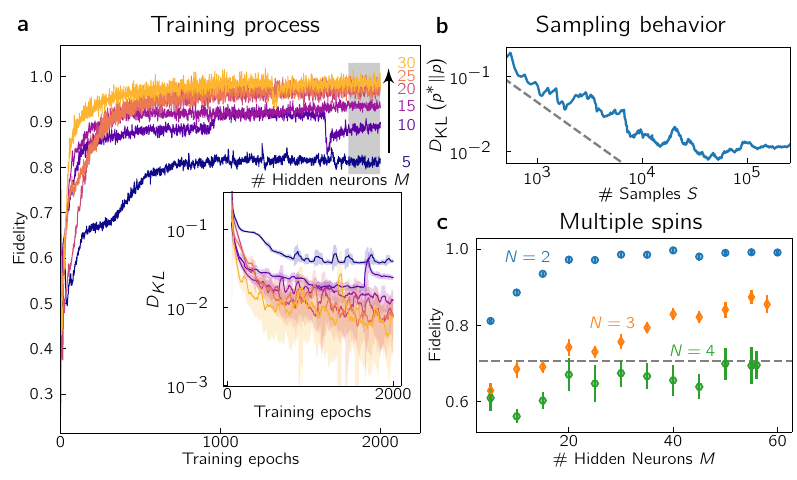
Figure 3: Training performance. a , Dynamics of the learning procedure for the pure Bell state ρ . The quality of the network-encoded state is measured by the quantum B fidelity, Eq. (5) (main frame), and by the Kullback-Leibler divergence, Eq. (2) (inset), for different numbers of hidden neurons. For better visibility, the running average over 50 epochs is shown in the inset as solid lines, with the shaded areas indicat- ing the corresponding standard deviation. b , Kullback-Leibler divergence in a fixed trained network with M = 20 hidden neurons as a function of the number of samples drawn. The dashed line shows the expected trend for exact sampling from the target distribution. c , Quantum fidelity as a function of the number of hidden neurons for (cid:112) GHZ states | Ψ 〉 = ( |↑〉 ⊗ N + |↓〉 ⊗ N ) / 2 with N = 2 (Bell state), 3, and 4 qubits. We show the averages over 200 training epochs after convergence (gray shaded area in a ). The dashed line shows the bound for genuine N -partite